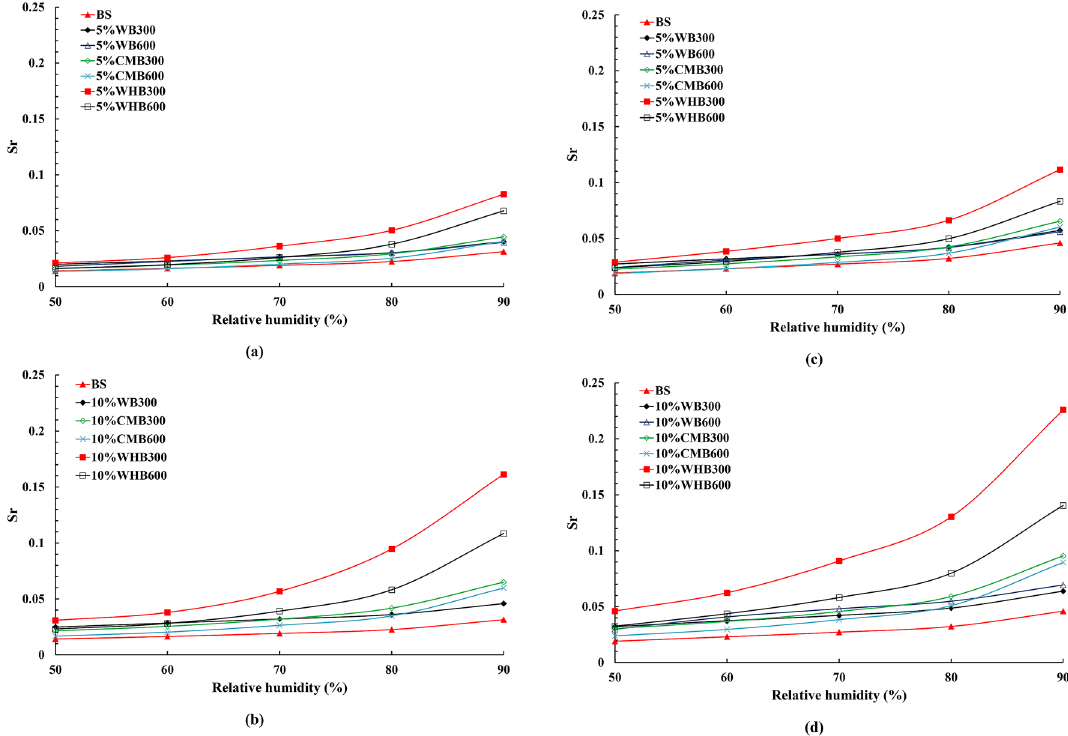
Figure 6. Saturation of ( a , b ) loose and ( c , d ) dense samples under different humidity